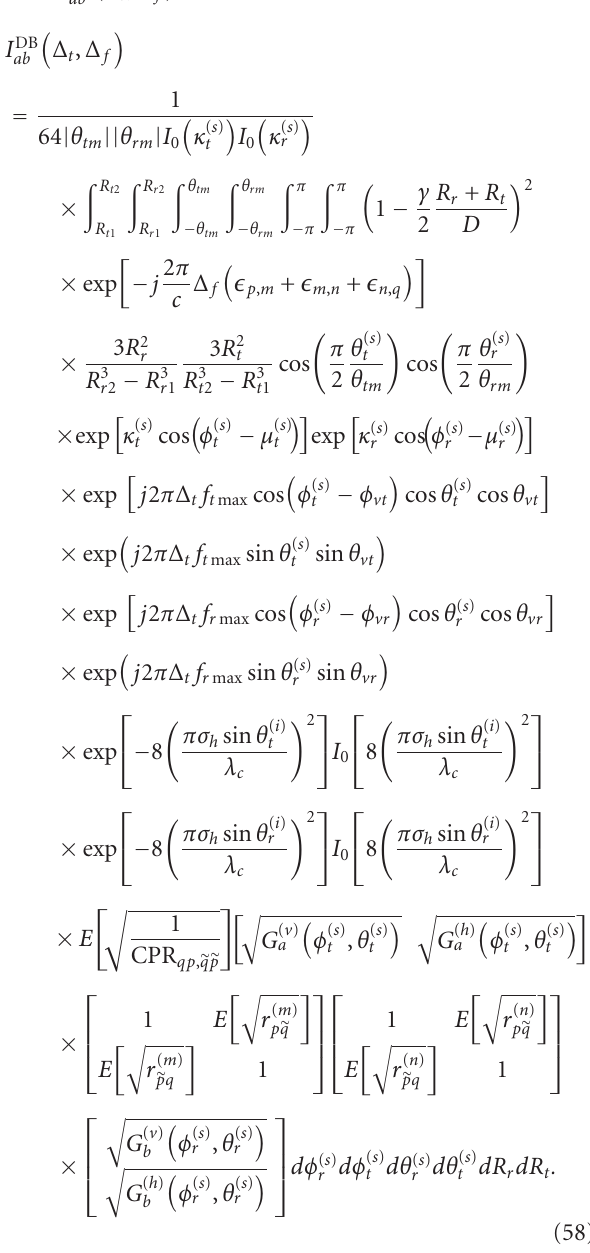
Table 1: The list of parameters used in the